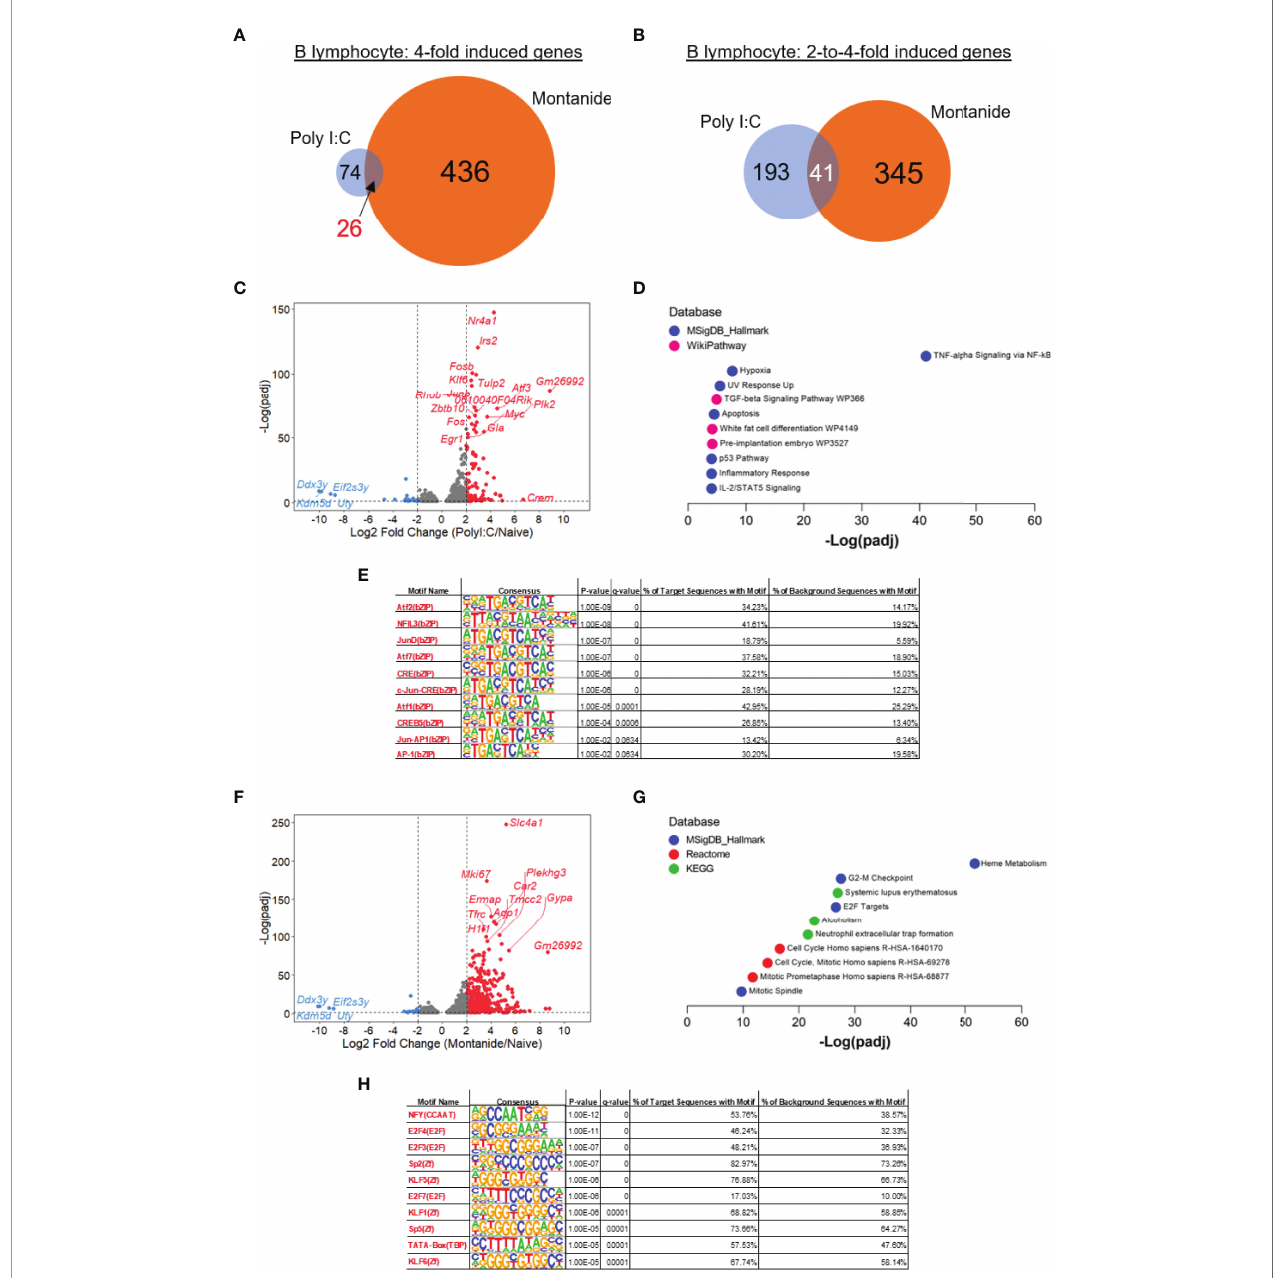
FIGURE 3 | Transcriptome analysis of B cells show a strong “ heme metabolism ” gene signature in Montanide-adjuvanted mice. Differentially expressed genes (DEGs) were determined with the R-Bioconductor DESeq2 package, using the raw reads from the different samples as input. Genes that displayed a p-adjusted < 0.05 were considered for downstream analysis. (A, B) , Venn diagrams depicting DEGs detected only in Poly (I:C)-adjuvanted, only in Montanide-adjuvanted or in both groups of mice. (C) , volcano plot highlighting the Poly (I:C)-induced DEGs. (D) , gene enrichment analysis of the 4-fold-induced genes by Poly (I:C). (E) , HOMER motif analysis in the promoters of 3-fold induced genes by Poly (I:C), performed with the Enrichr webtool. (F) , volcano plot highlighting the Montanide-induced DEGs. (G) , gene enrichment analysis of the 4-fold-induced genes by Montanide ISA 720. (H) , HOMER motif analysis in the promoters of 3-fold induced genes by Montanide ISA 720, performed with the Enrichr